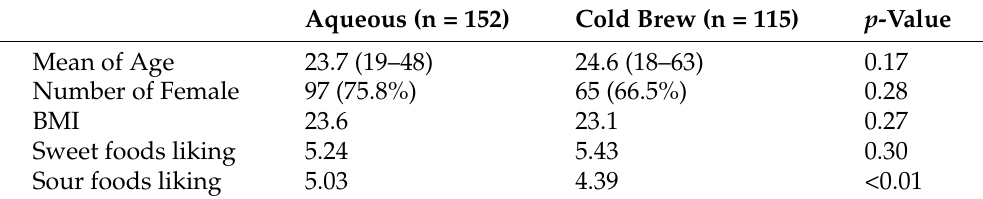
Table 2. Baseline characteristics of participants in aqueous solution and cold-brewed coffee sub- studies. Provided p -values of ANOVA for the difference between sub-studies. For age, range is in parenthesis, BMI is Body Mass